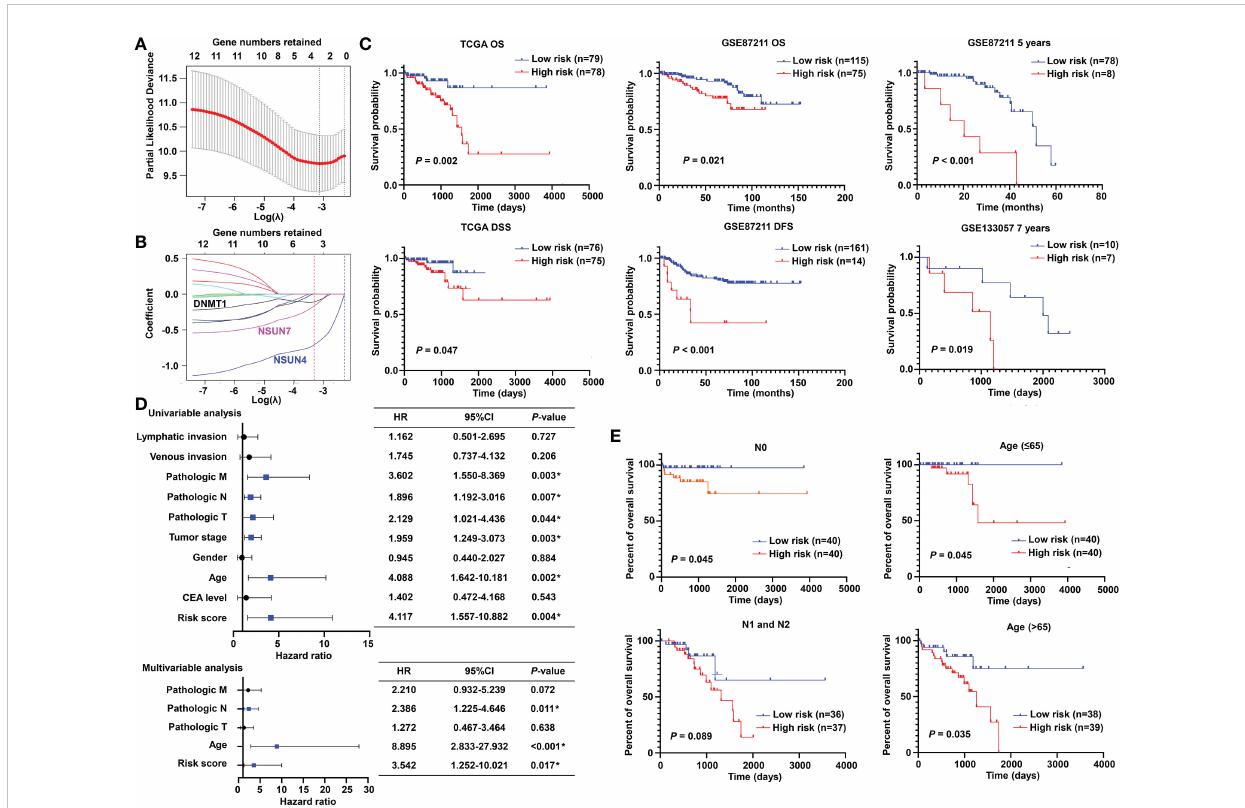
FIGURE 3 Prognostic signi fi cance of the m 5 C methylation-based signature in READ patients. (A) The process of LASSO regression based on the TCGA cohort and the identi fi cation of “ lambda ” for best selection of gene signature. (B) The curves indicate the tracks of single genes; the red dot line represents the target lambda. The blue track refers to NSUN4, pink track refers to NSUN7, and black line is DNMT1. (C) The Kaplan – Meier curves for OS and DSS between two categories in READ from the TCGA data set; the Kaplan – Meier curves for OS, 5-year survival based on the GSE87211 data set; the Kaplan – Meier curves for 7-year survival based on the GSE133057 data set. (D) The univariate and multivariate Cox analysis integrating risk score and clinicopathological indexes based on the TCGA cohort. (E) The prognostic ability of the risk score in distinguishing the overall survival status for READ patients with or without lymph node metastasis. The prognostic ability of the risk score in differentiating the overall survival status in patients with age less than 65 years or those with 65 years or more. CI, con fi dence interval; DFS, disease-free survival; DSS, disease-speci fi c survival; HR, hazard ratio; OS, overall survival. * P <